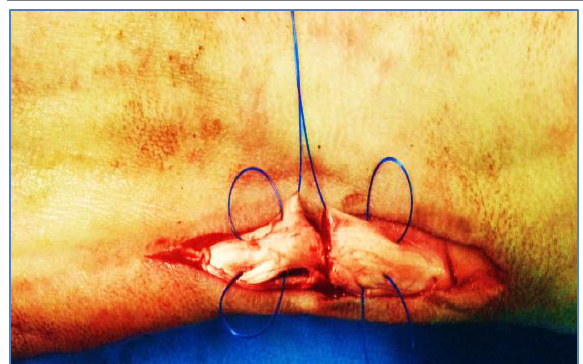
Figure, 3: Suturing Achilles tendon with Kessler pattern (two loops on each side).